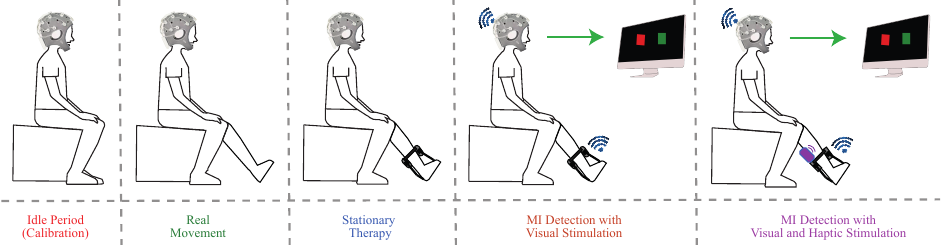
Figure 5. Experimental BCI T-FLEX system procedure in post-stroke patients with lowerlimb impairment. The fourth and fifth last two captures belonged to the MI stage. Throughout the MI ankle to command T-FLEX. In these captures, visual or visual with haptic inducement test, lasting approximately 30 to 40